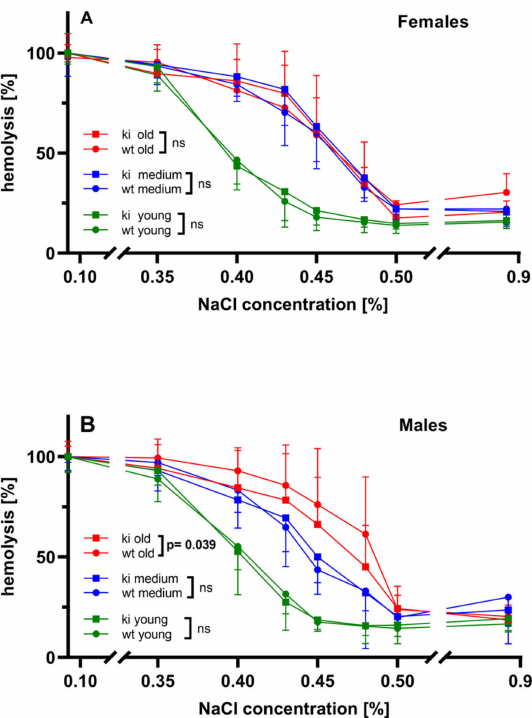
Figure 8. Comparison of the susceptibility of erythrocytes prepared from Alox15b -KI mice and from outbred wildtype controls for osmotic challenge. Alox15b -KI mice and outbred wildtype controls of either sex were classified in three age categories (young mice, 10–20 weeks; middle-aged mice, 30–40 weeks; old mice, 70–80 weeks, n ≥ 5 for each age-group with 2–3 replicates/individual). After sacrificing the animals by cervical dislocation under anesthesia, EDTA blood was removed and the susceptibility of the red blood cells for osmotic challenge was quantified as described in Section 2. The degree of hemolysis was calculated and these data are plotted over the NaCl concentration. Under strongly hypo-osmotic conditions (water, no NaCl), all erythrocytes (100%) hemolyzed. Under iso-osmotic conditions (0.85% NaCl), more than 80% of the red blood cells survived the hemolysis period. ( A ) Female mice, ( B ) male mice. ns, no significant